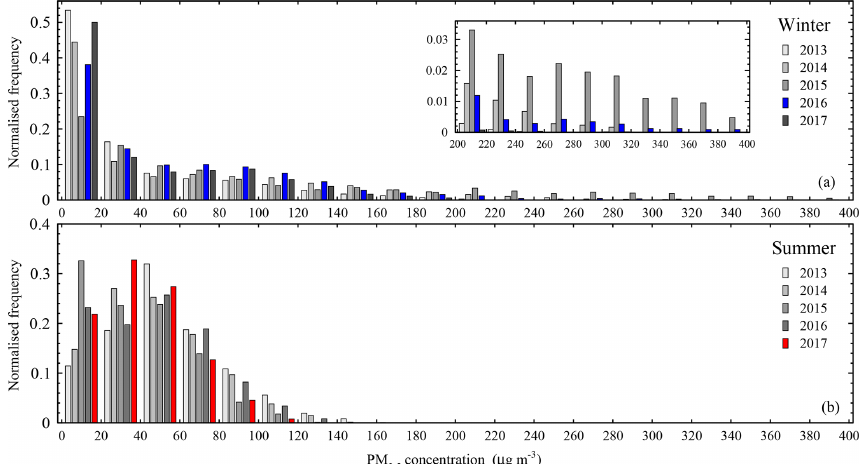
Figure 12. Frequency distribution of PM 2 . 5 in Beijing over the winter (a) and summer (b) campaign periods from the NAQPMS model compared with those from the same periods over the past 5 years under the same emission